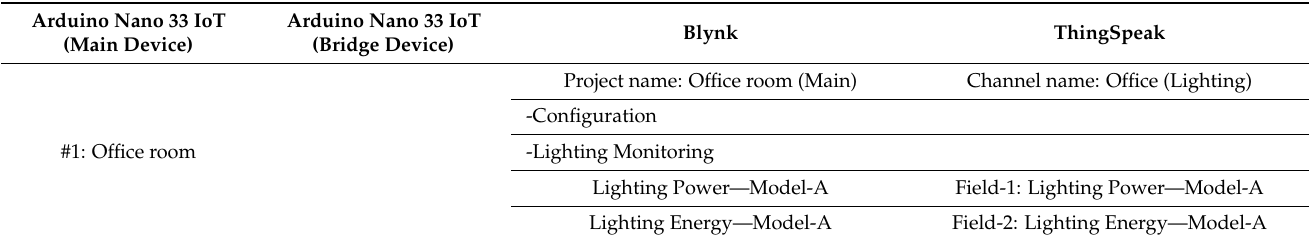
Table 3. Arrangement of monitored data of the Office room